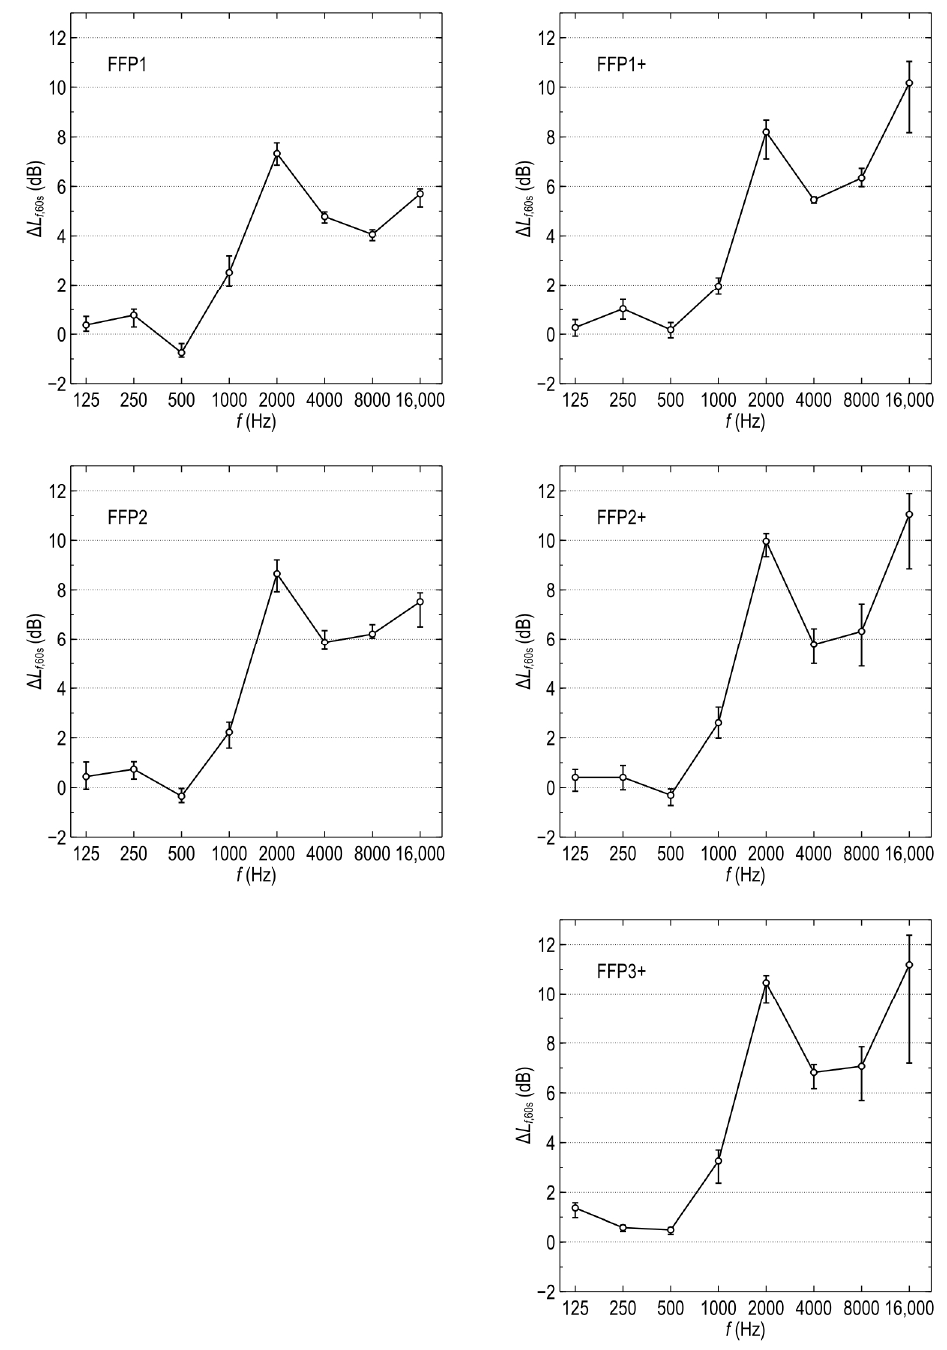
Figure 3. Attenuation of sound by the five FFPs in octave bands with center frequencies f . Points— averaged values ∆ L f ,60s (cf. Table 2), whiskers—minimum-maximum range. Lines are guides for the eye only. Plus sign in the FFP symbol denotes a mask with an exhalation